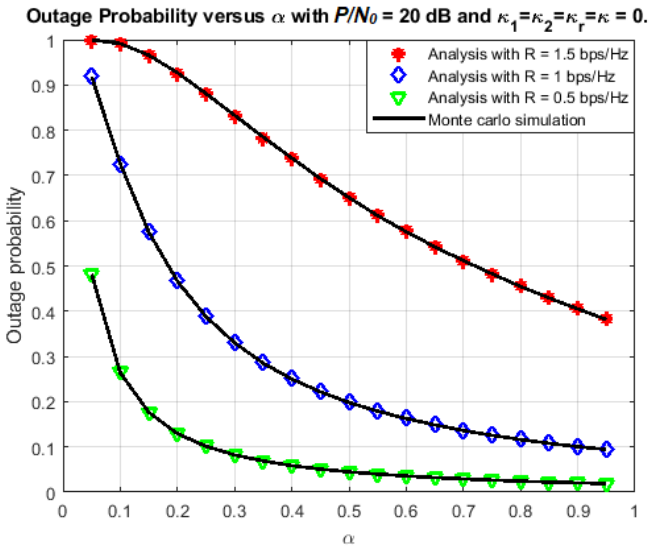
Figure 7. Outage probability versus α